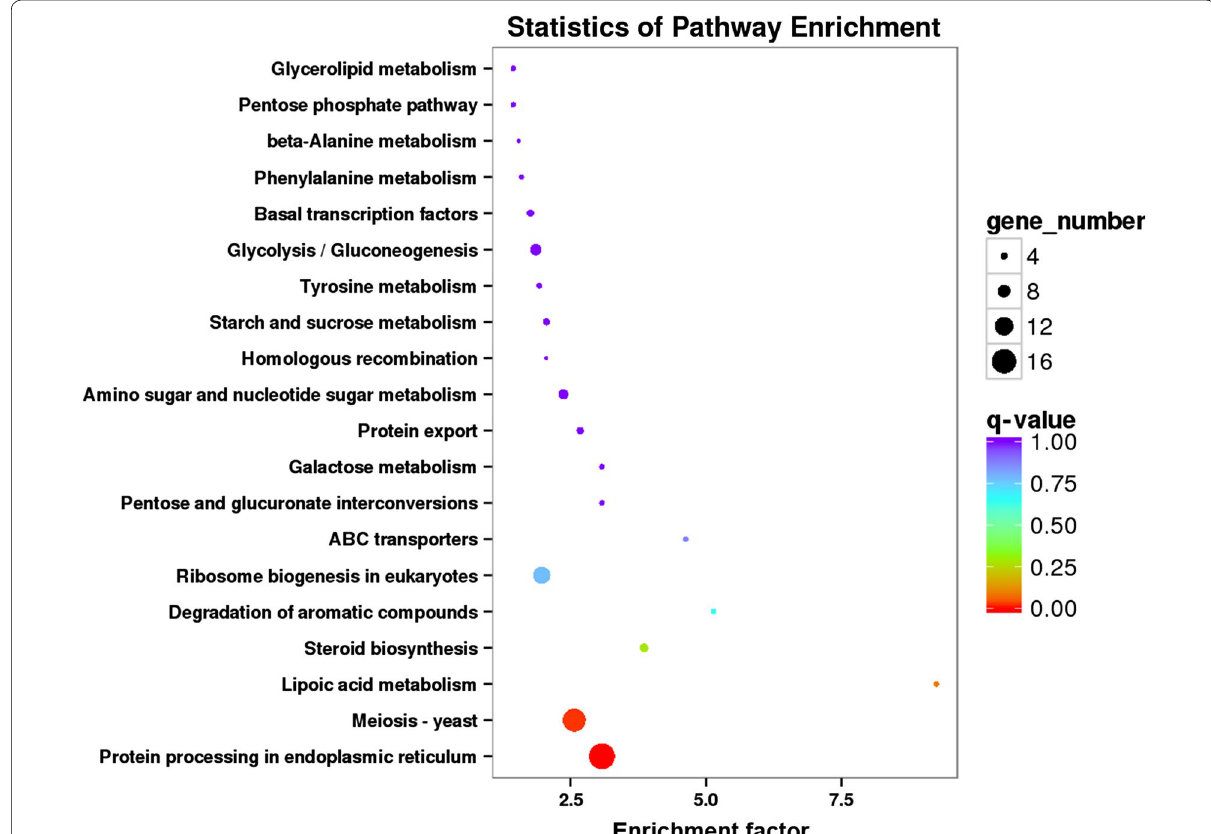
Fig. 5 KEGG pathways enrichment analysis. The diameter of the circle is proportional the number of DEGs enriched in each pathway. The color of circle represents the q-value for